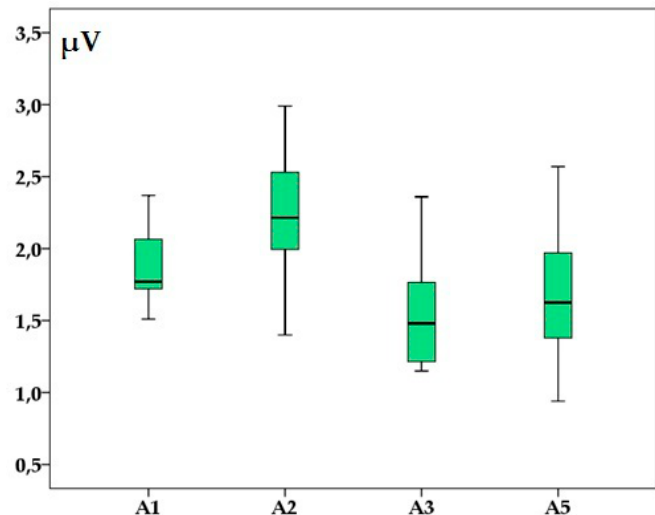
Figure 3. Brainstem auditory evoked response’ amplitudes (in microvolts) of waves I (A1), II (A2), III (A3) and V (A5) in adult healthy raccoon dogs after a 90 dB SPL stimulus was applied. Boxplots represent the cumulative values from all individuals after two consecutive left, right and binaural stimulations.